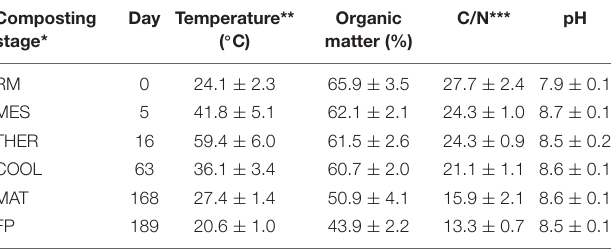
TABLE 1 | Sampling times and main characteristics of